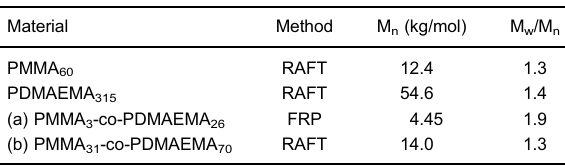
Table 1. Synthesis parameters and selected characterization data.